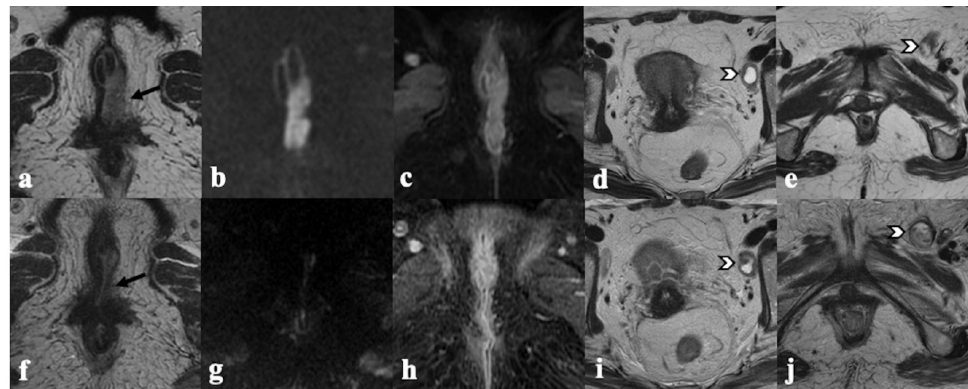
Figure 3. Partial response after CRT. A 73-year-old patient with locally advanced vulvar cancer (FIGO stage IVA) presenting with an intermediate T2 signal intensity mass involving left labia minor and major (( a )—black arrow), with hyperintensity in DWI ( b ) and enhancement in T1-WI post-contrast ( c ) and ulcerated pelvic (( d )—white arrowhead) and left inguinal (( e )—white arrowhead) lymph nodes. MRI after CRT (bottom row) shows significant lesion size reduction in both T2W (( f )—black arrow), DWI ( g ) and post-contrast T1W images ( h ), but dimensional increase in regional lymph nodes (( i , j )—white arrowheads), consistent with partial response. Differentiating a residual tumor from post-treatment fibrosis is not always straightforward. In fact, radiologists tend to overestimate residual disease when